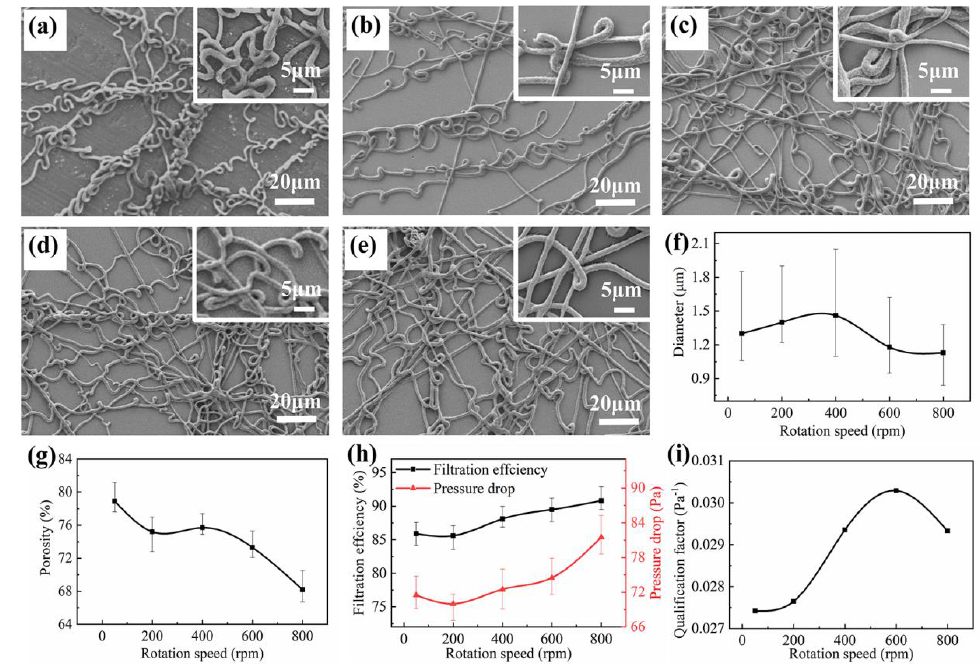
Figure 7. The SEM image, nanofiber diameter and filtration performance of nanofibrous membrane with roller speed. ( a – e ) SEM image of PVDF nanofibrous membrane at the roller speed of 50 rpm, 200 rpm, 400 rpm, 600 rpm and 800 rpm, respectively; ( f – i ) diameter, porosity, filtration efficiency and pressure drop, QF of PVDF nanofibrous membrane at different roller speeds, respectively. The distance between electrode and collector, the voltage and the electrospinning time was 3.0 cm, 5 kV and 60 min, respectively.